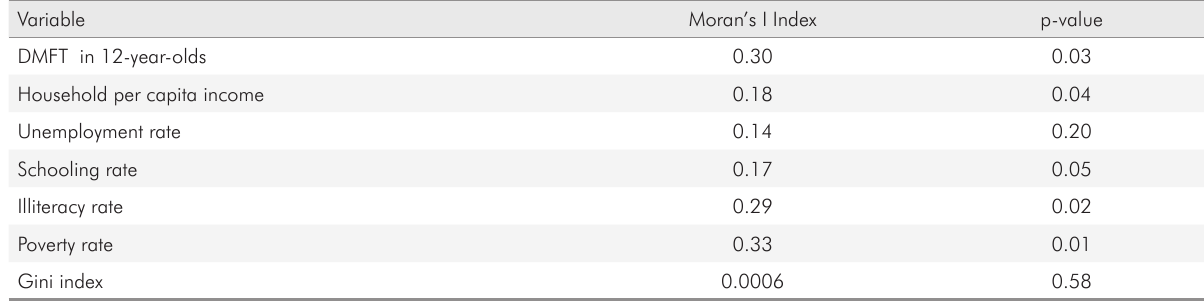
Table. Spatial autocorrelation of the study